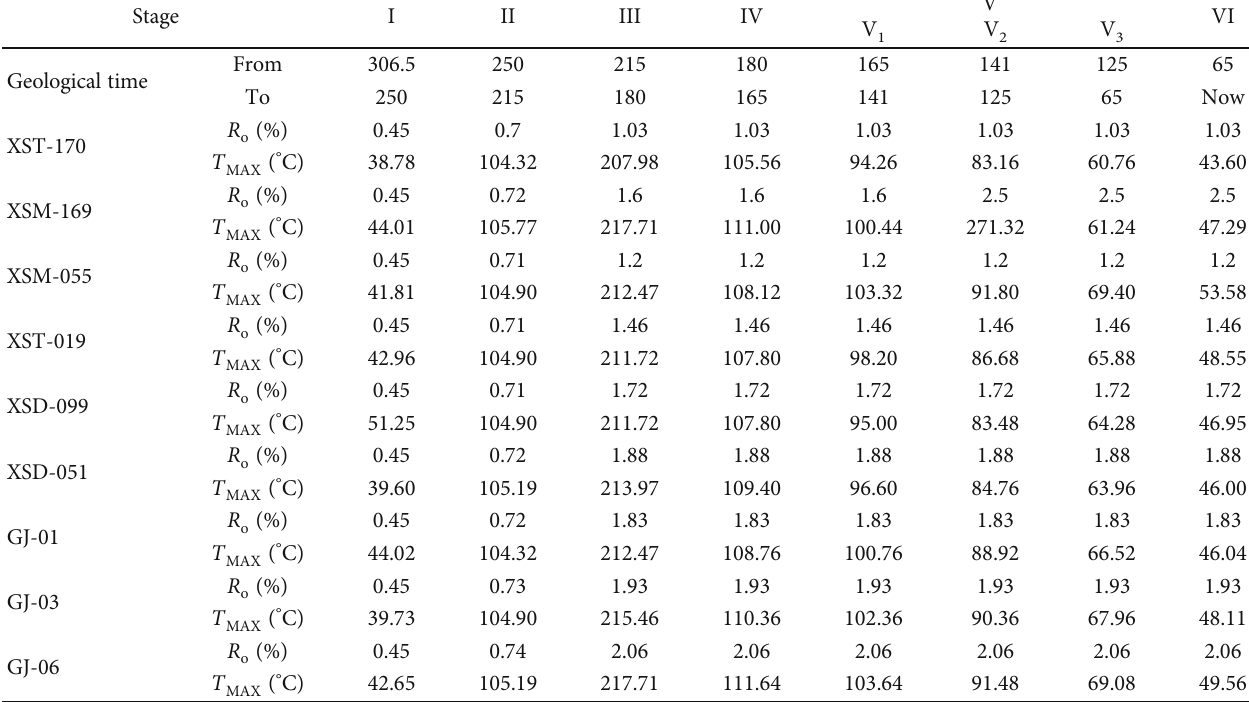
Table 2: The vitrinite re fl ectance and reservoir temperature of the coal reservoir during geothermal evolution processes.